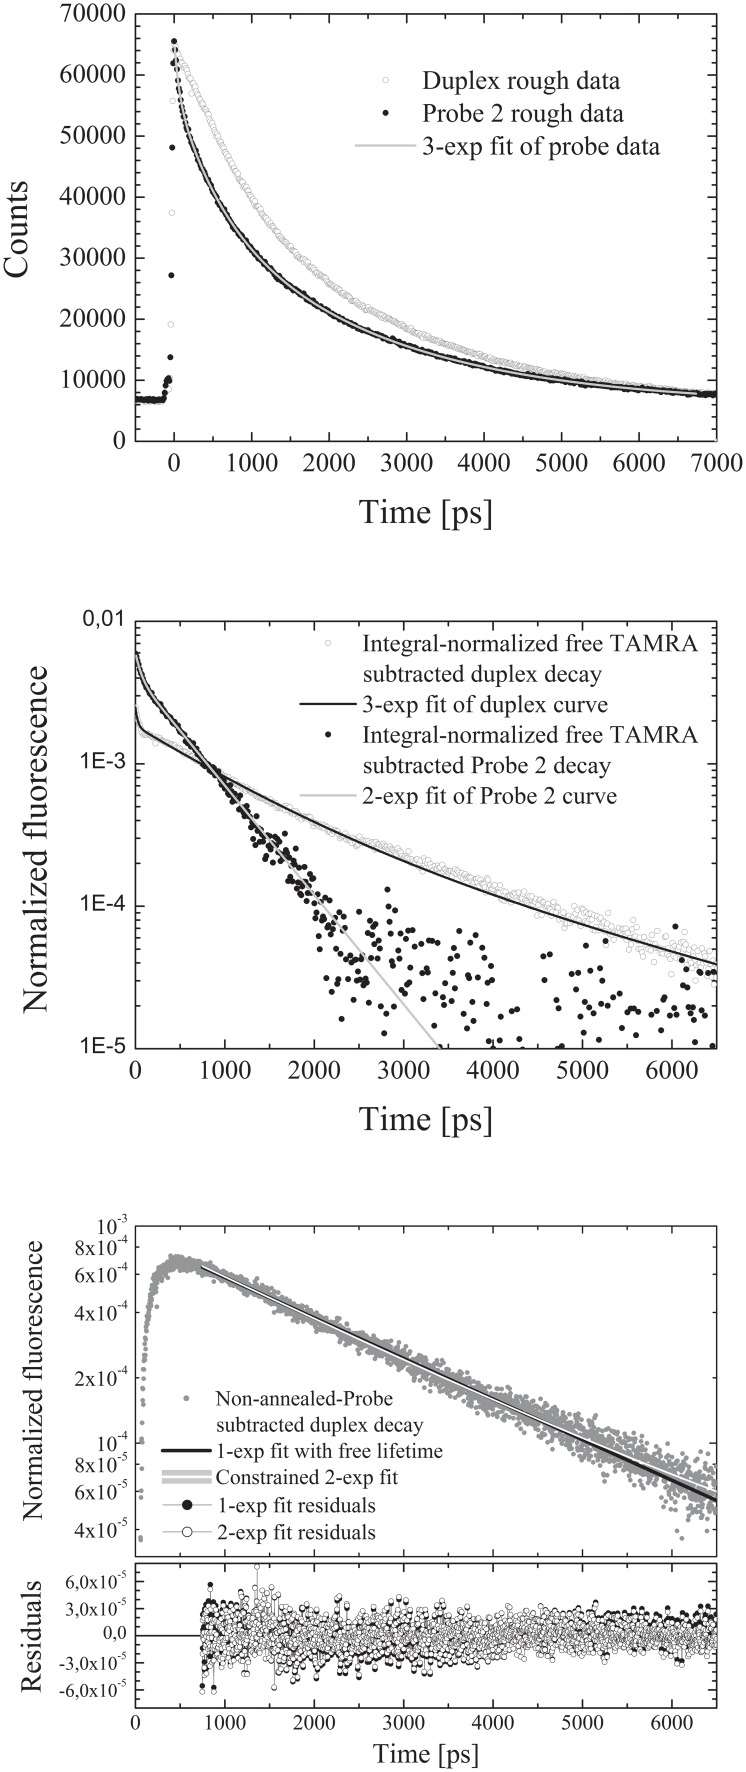
Main steps of the data cleaning procedure shown for an exemplary dataset, namely one of those obtained with the DQB1-0201/0301 genotype mimicking oligonucleotide mixture annealed to Probe2.Upper panel: the decay patterns of the single-stranded probe and of the duplex are synchronized and the probe decay is fitted to a three-exponential-components model. Central panel: the longest lived component of the fit, which is attributed to non-quenched TAMRA emission, is subtracted to both the probe and the duplex distributions, which are then normalized to their integrals and fitted to a 2-exponential and a 3-exponential model, respectively. Lower panel: the weighted subtraction of the non-hybridized probe fraction to the duplex decay yields the net decay of TAMRA molecules attached to intact (i.e. bearing also BHQ2) and correctly hybridized probes. The latter can either be interpolated with a single-exponential or fitted to a constrained 2-exponential model in which the decay time constants values are fixed to those measured for any pair of alleles, the relative amplitudes are allowed to vary and their values analyzed in order to derive the correct genotype (see text for details). In the figure the 2-exponential fitting curve obtained by using the decay time constant values pertaining to the correct pair of alleles is reported.